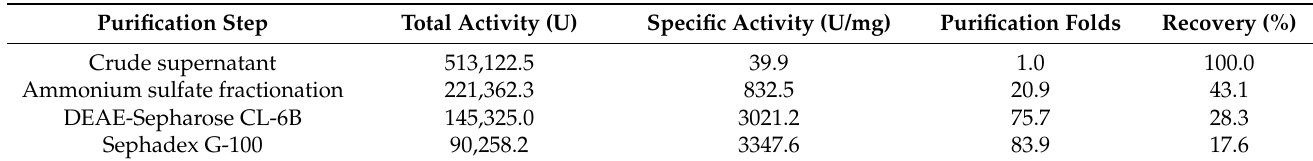
Table 1. A brief of protease purification steps.